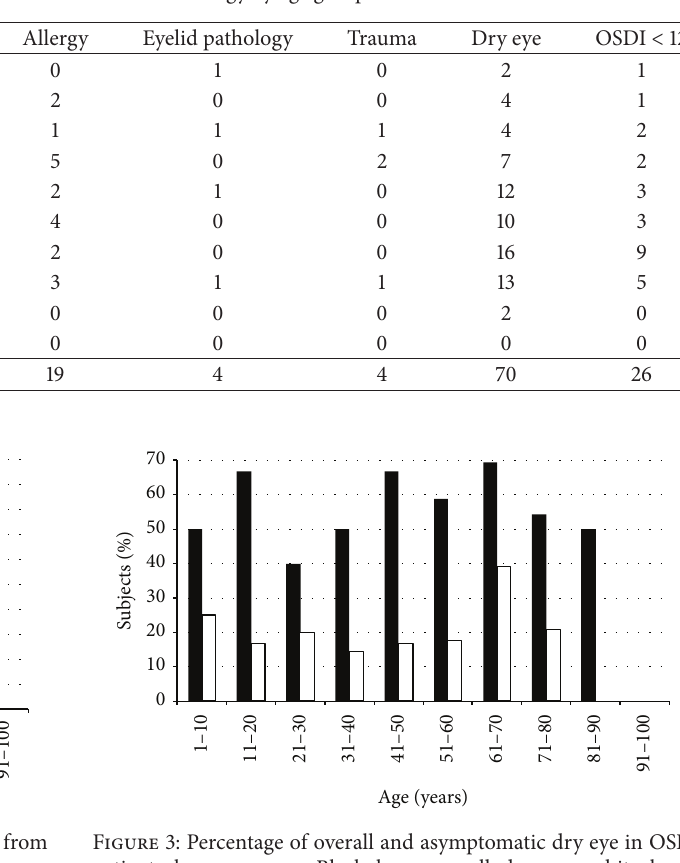
Table 2: Prevalence and distribution of OSD etiology by age group.